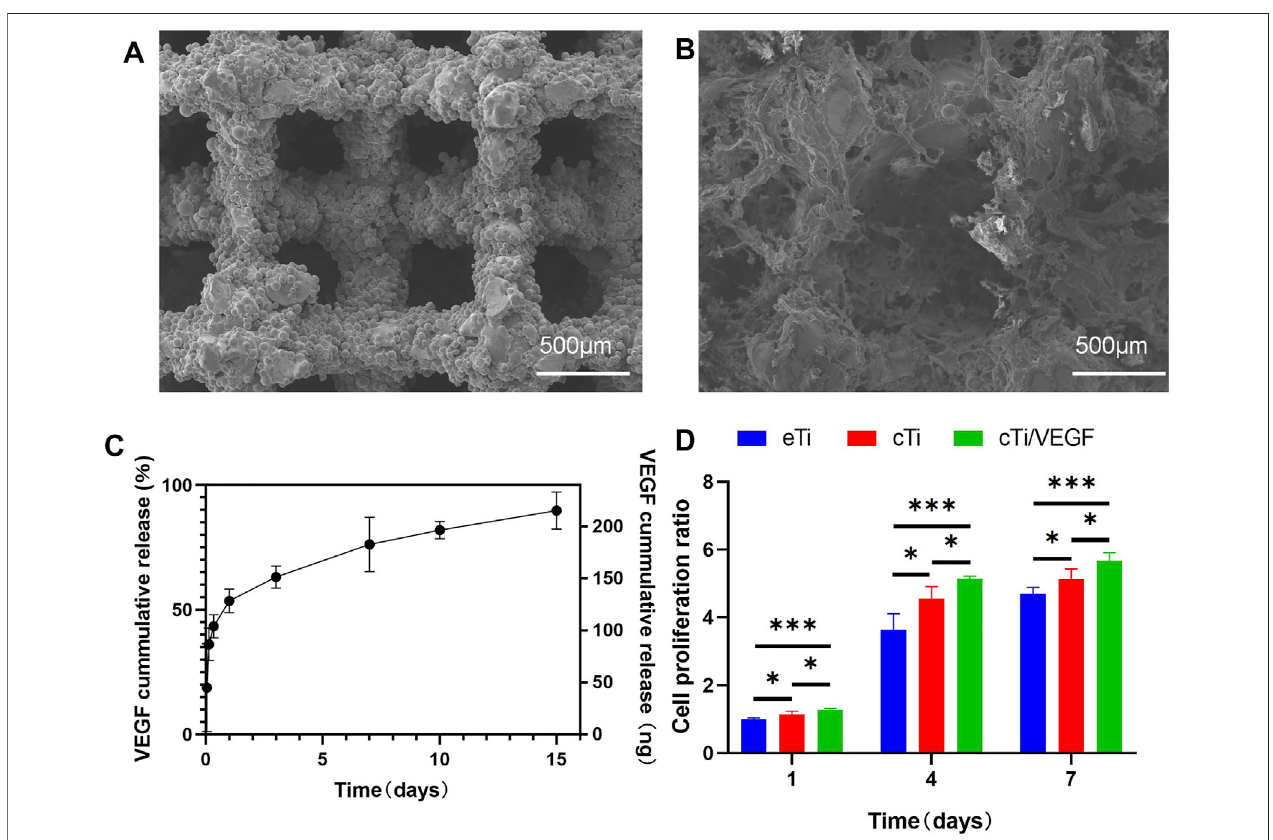
FIGURE 1 | Microscopic characterization of eTi (A) and cTi (B) , using SEM scanning images (C) VEGF release curve in vitro within 15 days (D) Analysis of the HUVECs proliferation in each group, using the eTi of the fi rst day as a reference (n (cid:1) 3, *indicates signi fi cant differences between groups, * p < 0.05; ** p < 0.01; *** p <